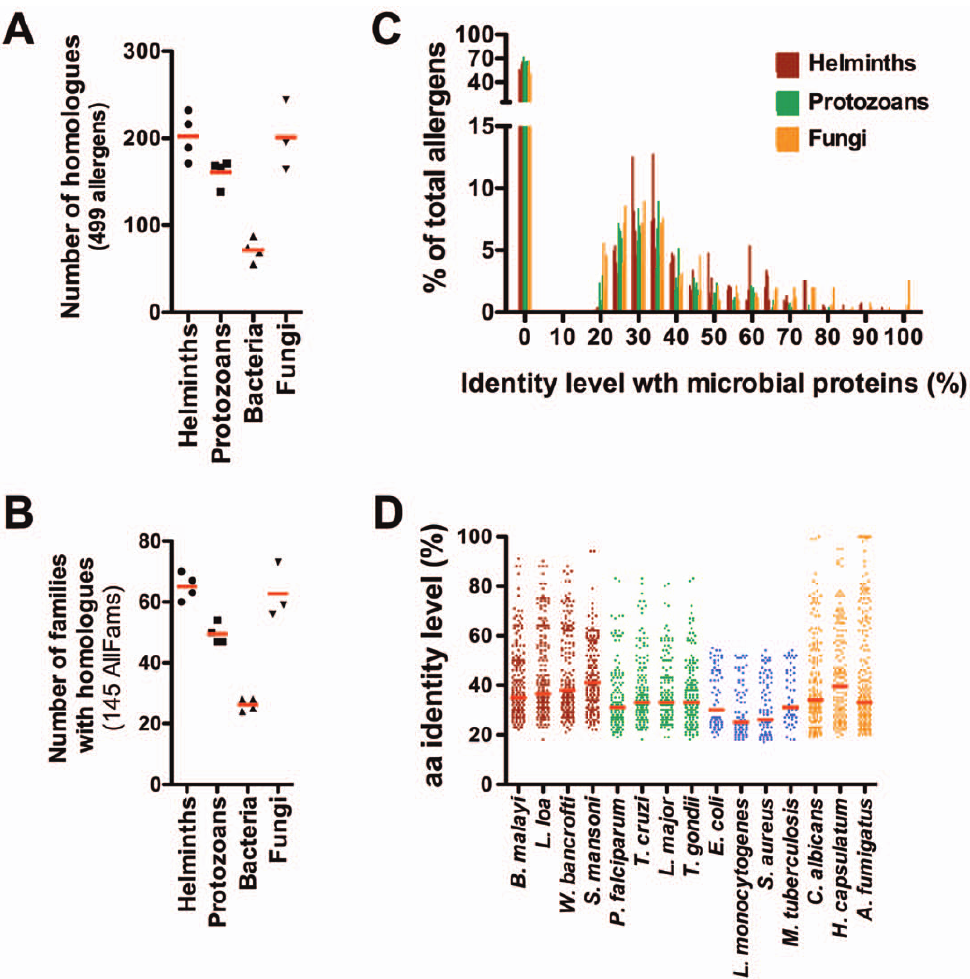
Figure 1. Allergens display large number of homologues in the genomes of helminths, protozoa and fungi. A , The number of homologues; B , the number of allergen families (AllFams) with homologues; and C , the frequency distribution of the homologues binned by the level of identity were assessed between allergens and the predicted proteomes of various microbial genera. Each dot ( A and B ) or spike ( C ) represents each microbe listed. D , Identity level between allergens and microbial pathogen proteins. Each dot represents an individual allergen with the identity level on the y-axis for a particular pathogen listed on the x-axis. Dots are colored coded to represent helminths in brown, protozoans in green, bacteria in blue and fungi in orange. The horizontal line represents the geometric mean for each pathogen listed.